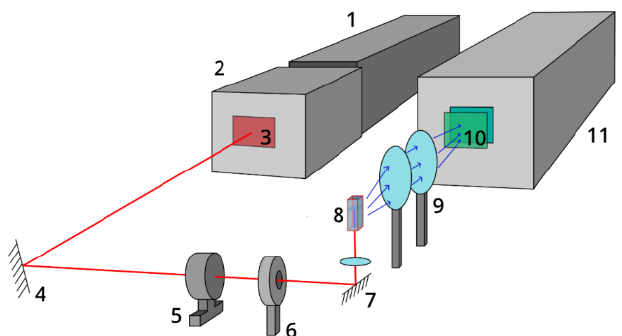
Figure 4. Scheme of the experimental setup for the study of CDs’ UCL: 1—pulsed nanosecond Nd:YAG laser; 2—parametric light generator; 3—light filter KS-11; 4—rotatory mirror; 5—power meter; 6—mechanical shutter; 7—rotatory mirror and lens; 8—cuvette with the solution of nanoparti- cles; 9—optical system of two lenses; 10—light filters SZS-22 and SZS-23; 11—registration system consisting of a monochromator and a CCD camera.